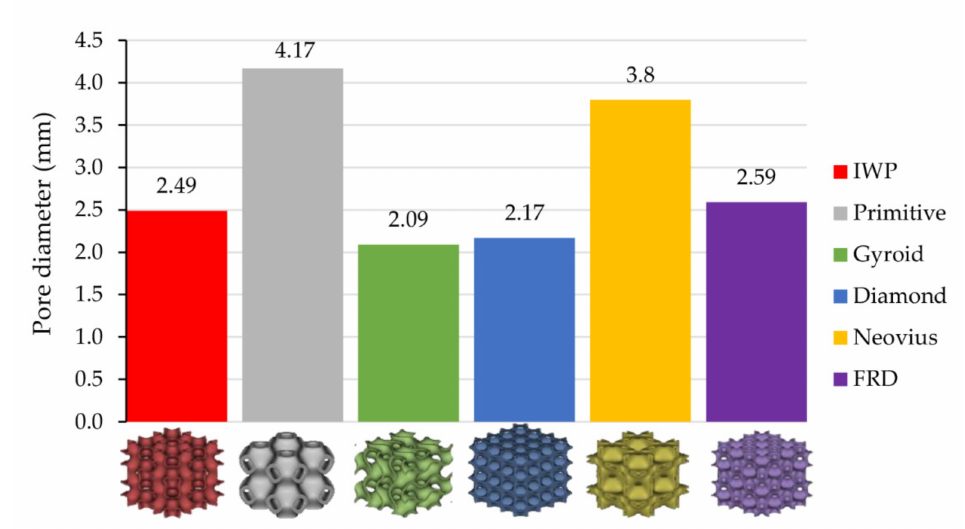
Figure 16. The value of pore diameter, D pore , of each TPMS structure.